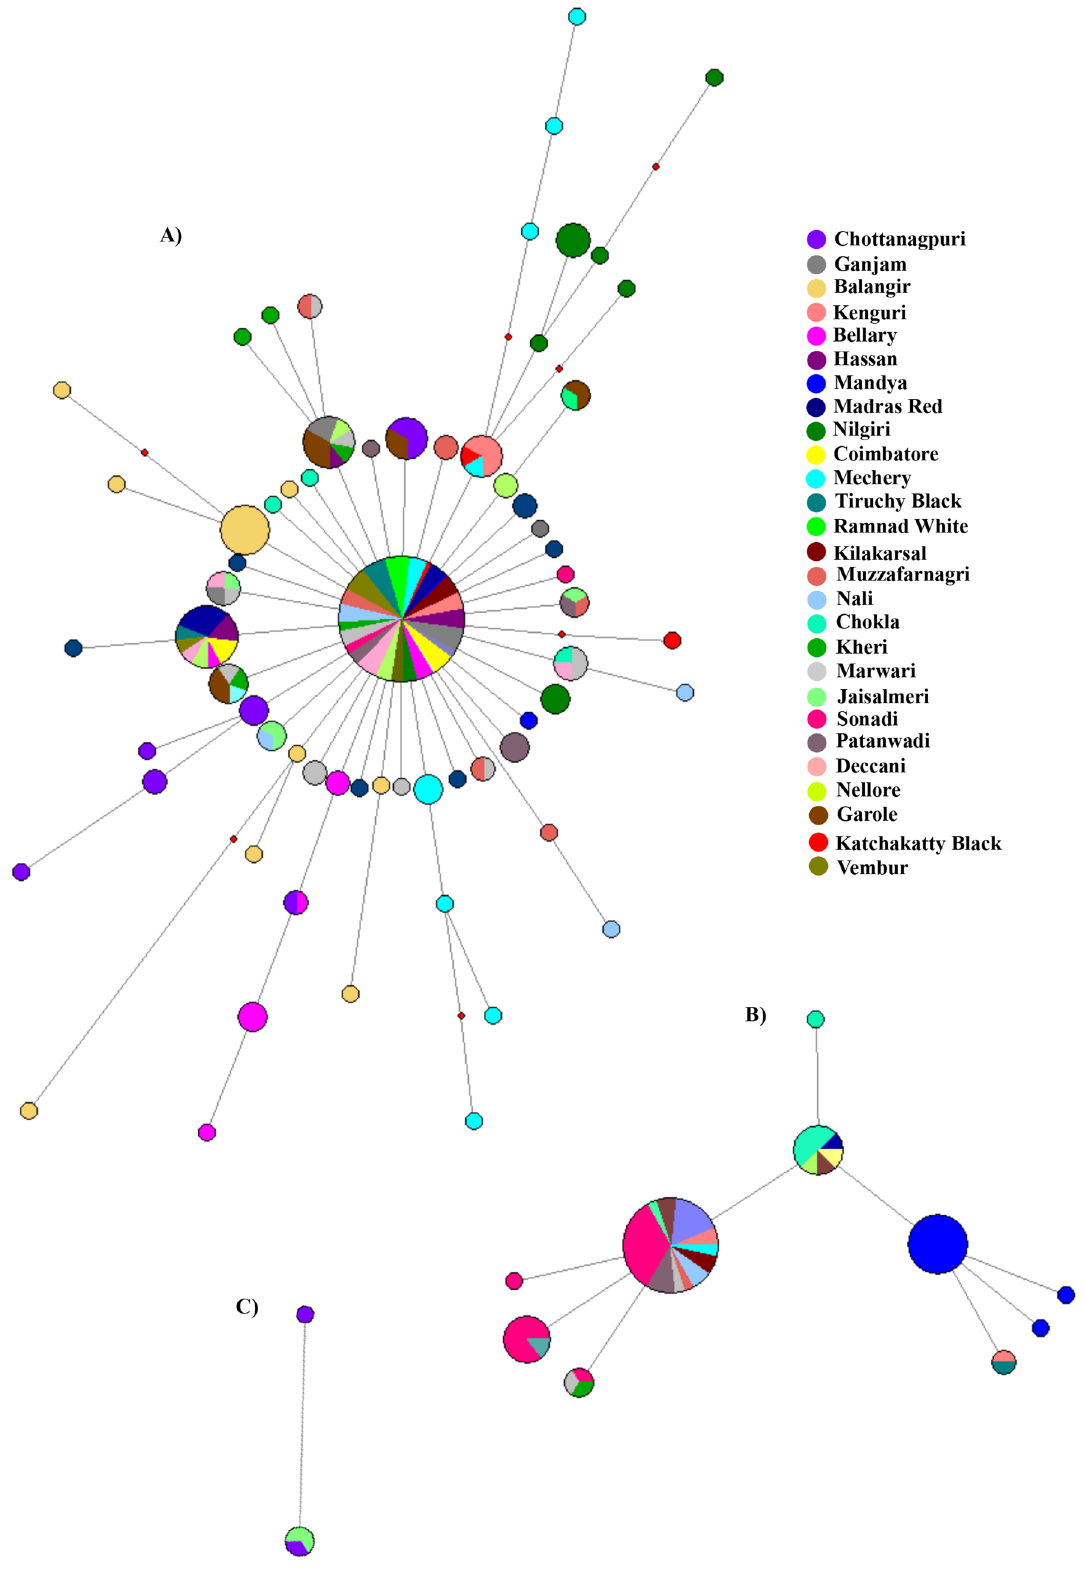
Figure 7. Median-joining network of Indian domestic sheep lineage A, B and C of CYTB gene sequences. ( A ) The MJ network of lineage A was constructed using 667 CYTB gene sequences (737 bp) of 27 Indian sheep breeds. ( B ) The MJ network of lineage B was constructed using 67 CYTB gene sequences (737 bp) of 17 sheep breeds. ( C ) The MJ network of lineage C was constructed using 4 CYTB gene (737 bp) sequences of two sheep breeds. Size of the node is proportional to the number of sheep present in the node. The length of the line is proportional to the number of mutations. Sheep breeds are indicated by different colours. The small red rectangles represent the median vector. The network was constructed using Network 10.2.0.0 17 and edited in Inkscape 1.0 (https:// inksc ape.